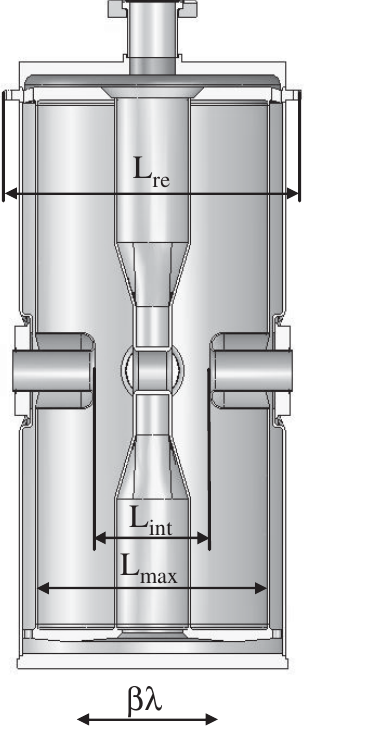
FIG. 5. (Color) Beam steering (without compensation) and rf defocusing vs (cid:1) in the low- and medium- (cid:1) cavities, at operation FIG. 4. Different definitions ( L , L , and (cid:1)(cid:2) ) in use for L , int max ac gradient and (cid:2) 30 (cid:8) synchronous phase. the resonator active length, sketched in a low- (cid:1) HWR sche- represents the maximum physical length of the matic. L re resonators along the beam axis.